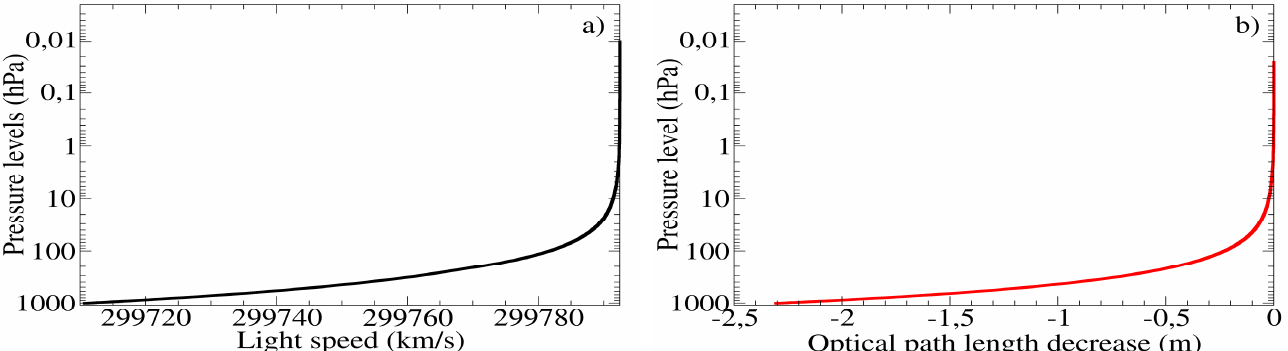
Figure 11. For the pressure levels in hPa of a standard atmosphere: ( a ) the speed of light in km/s; ( b ) the distance offset in m if the speed of light is assumed to be the same as in the vacuum.